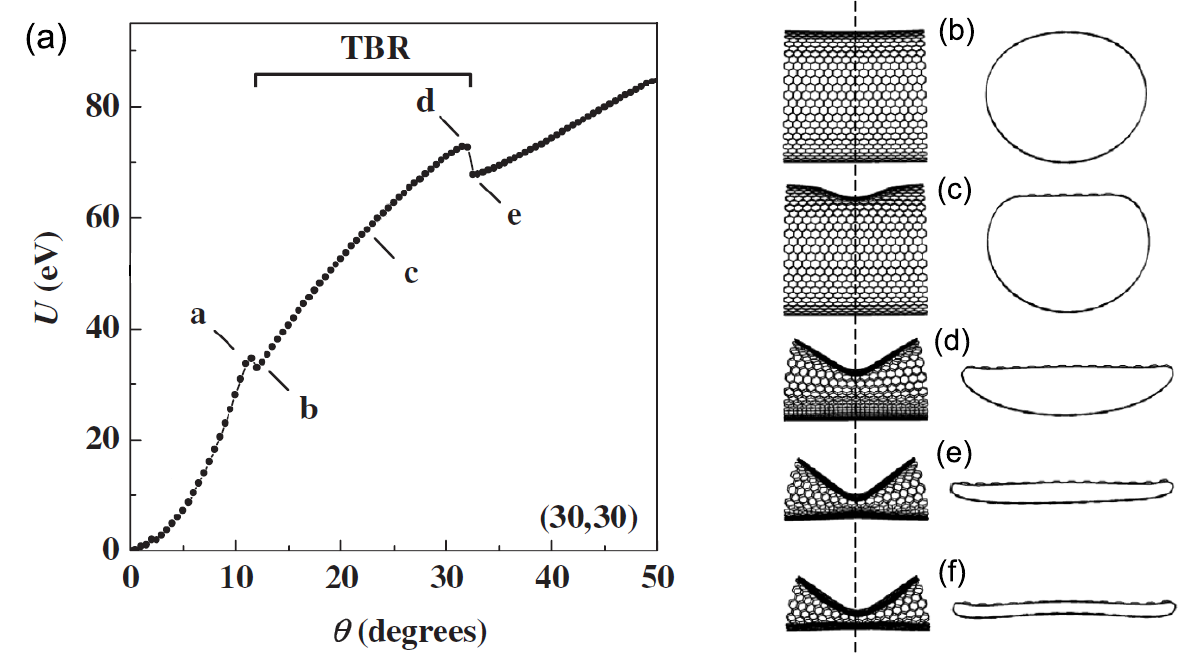
Figure 12. ( a ) Deformation energy U for a 23.6-nm-long (30,30) SWNT as a function of the bending angle θ . The symbols a–e attached to the curve indicate the points for which the tube shape and cross section at the buckling point are shown in the images ( b )–( f ) on the right. “TBR” denotes the transient bending regime. Reprinted from Reference